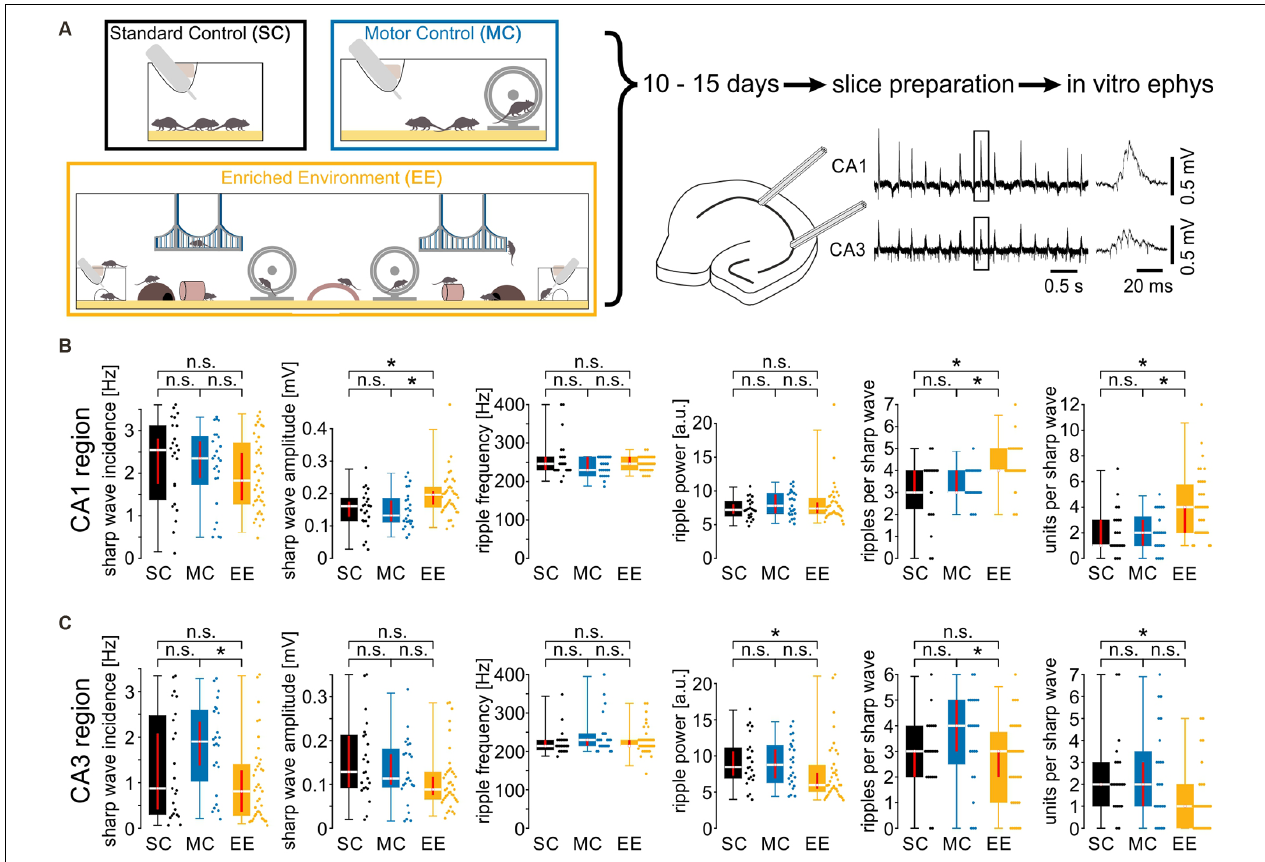
FIGURE 1 | Environmental enrichment increases amplitude, ripple cycles, and unit activity during sharp wave-ripple oscillations. (A) Mice were kept in one of three housing conditions for 10–15 days: standard conditions, motor control, or enriched environment (for details, see “Materials and Methods” section). Subsequently, hippocampal slices were prepared to record local field potentials and unit discharges during spontaneous sharp wave-ripple oscillations. (B) Sharp wave amplitudes, ripples per sharp wave and units per sharp wave were increased in the CA1 region of slices from EE animals. (C) Activity in the CA3 region did not show any consistent alterations. N = 23 slices from six mice for standard conditions, N = 25 slices from five mice for motor control, and N = 39 slices from eight mice for environmental enrichment. Asterisks denote p -values < 0.05 from post-hoc testing followed by a significant Kruskal-Wallis test. Red lines depict the confidence intervals of the median assessed by bootstrapping. n.s., not